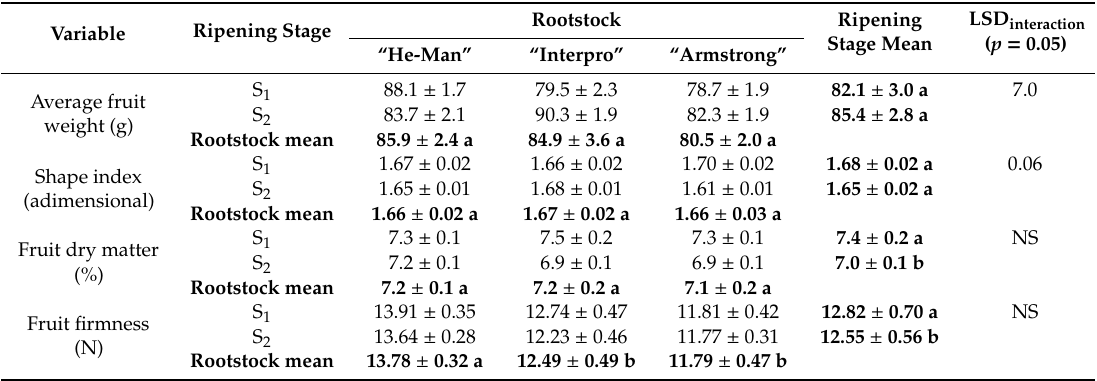
Table 2. Carpometric traits of tomatoes “Sir Elyan” as a ff ected by rootstock and ripening stage (mean ± standard error). Di ff erent letters among factor means (bold numbers) indicate significance at Fisher’s LSD test ( p = 0.05). NS: not significant.